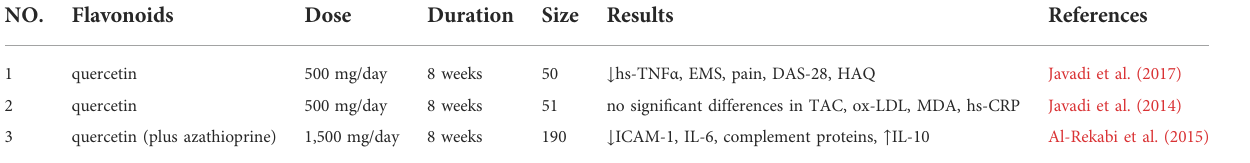
TABLE 4 An overview on clinical trials evaluating effects of compounds involved in EH on